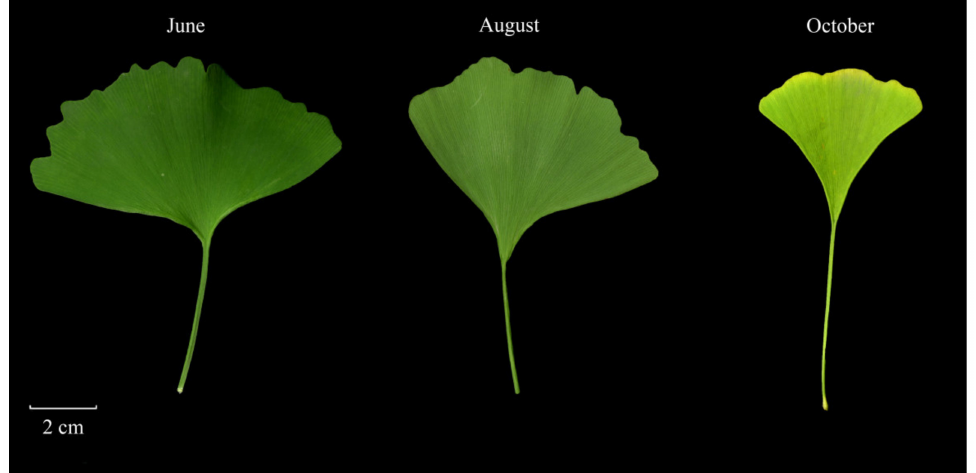
Figure 1. Sampled tissues in the female G. biloba tree across three